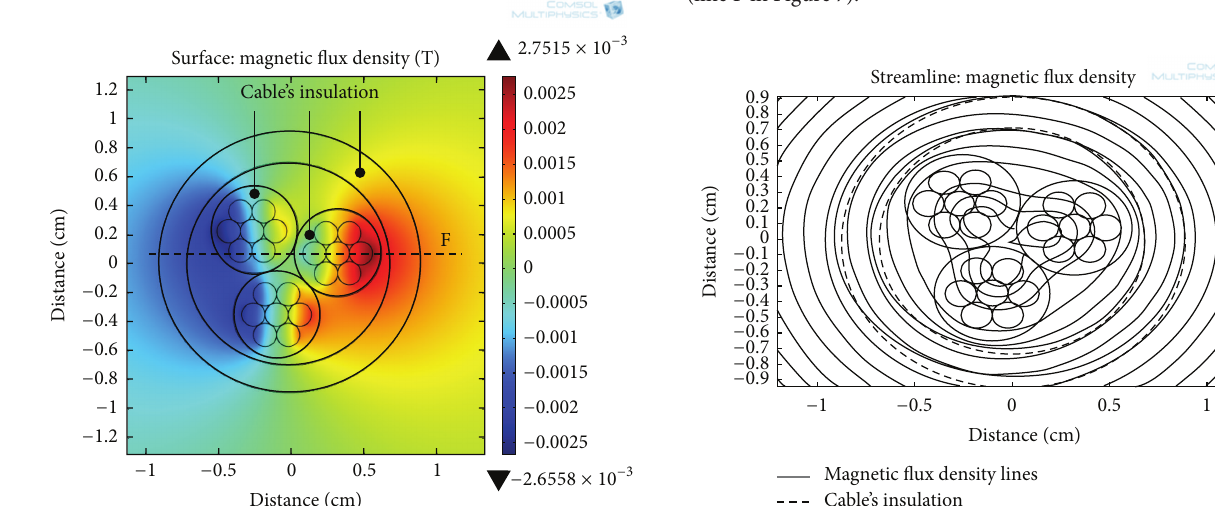
Figure 8: MFD as function of radial distance from the cable’s center (line F in Figure 7).